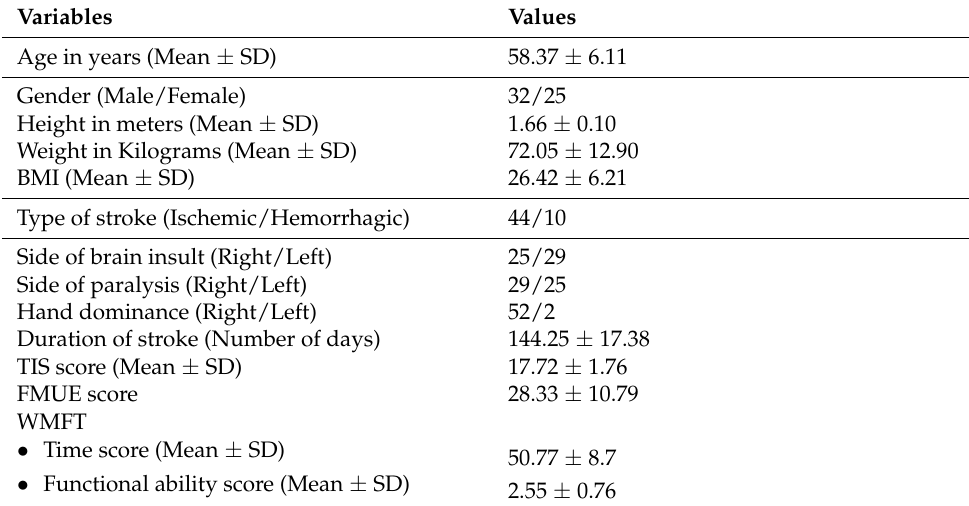
Table 1. Characteristics of the study participants ( n = 54).